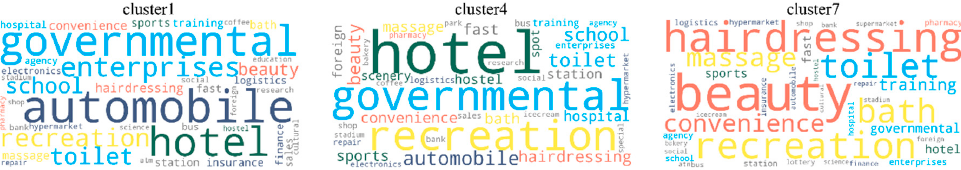
Figure 8. The semantic annotation result of different clusters when k = 5.